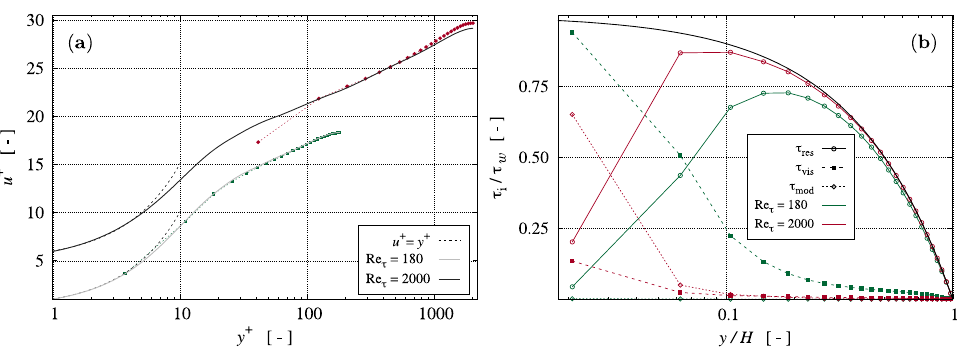
Figure 1. ( a ) Comparison of predicted non-dimensional mean velocity profiles u + = u / u τ as functions of the non-dimensional distance y + = y u τ / ν returned by the modified C-LBM for N H = 24 along the channel half height (symbols), the DNS data of Kim et al. [31] ( Re τ = 180 ) and the DNS data of Bernardini et al. [32] ( Re τ = 2000), indicated by solid lines. To improve the presentation, the mean velocity profile for Re τ = 2000 is shifted by ∆ u + = 5 velocity units in vertical direction. ( b ) Evolution of (averaged) resolved (solid/circles), viscous (dashed/squares), modeled (dotted/diamonds), and total (black line) normalized shear stress